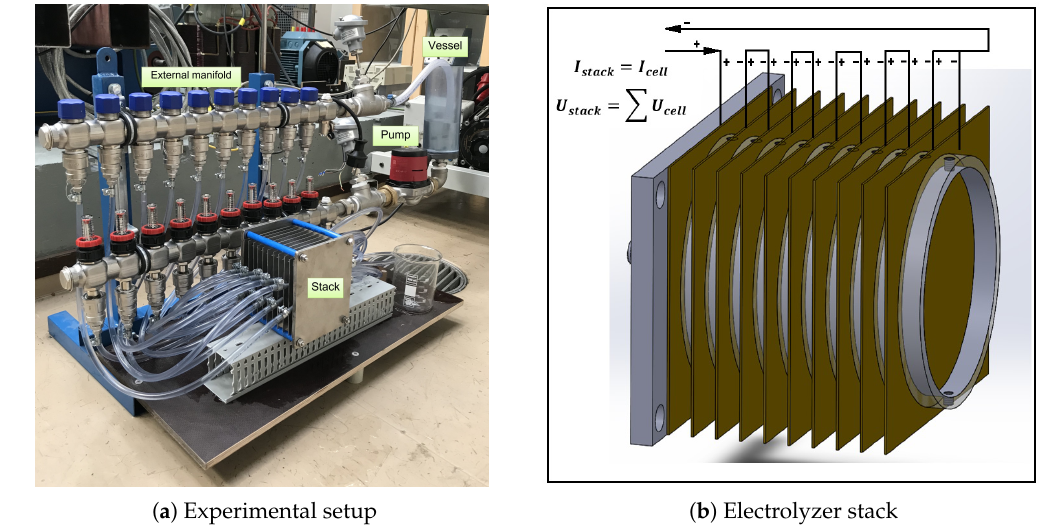
Figure 3. Experimental setup used for the electrolysis tests and a schematic of the electrolyzer stack. The ten cells are electrically connected in series, and the electrolyte flow is equally divided between the parallel cells by the